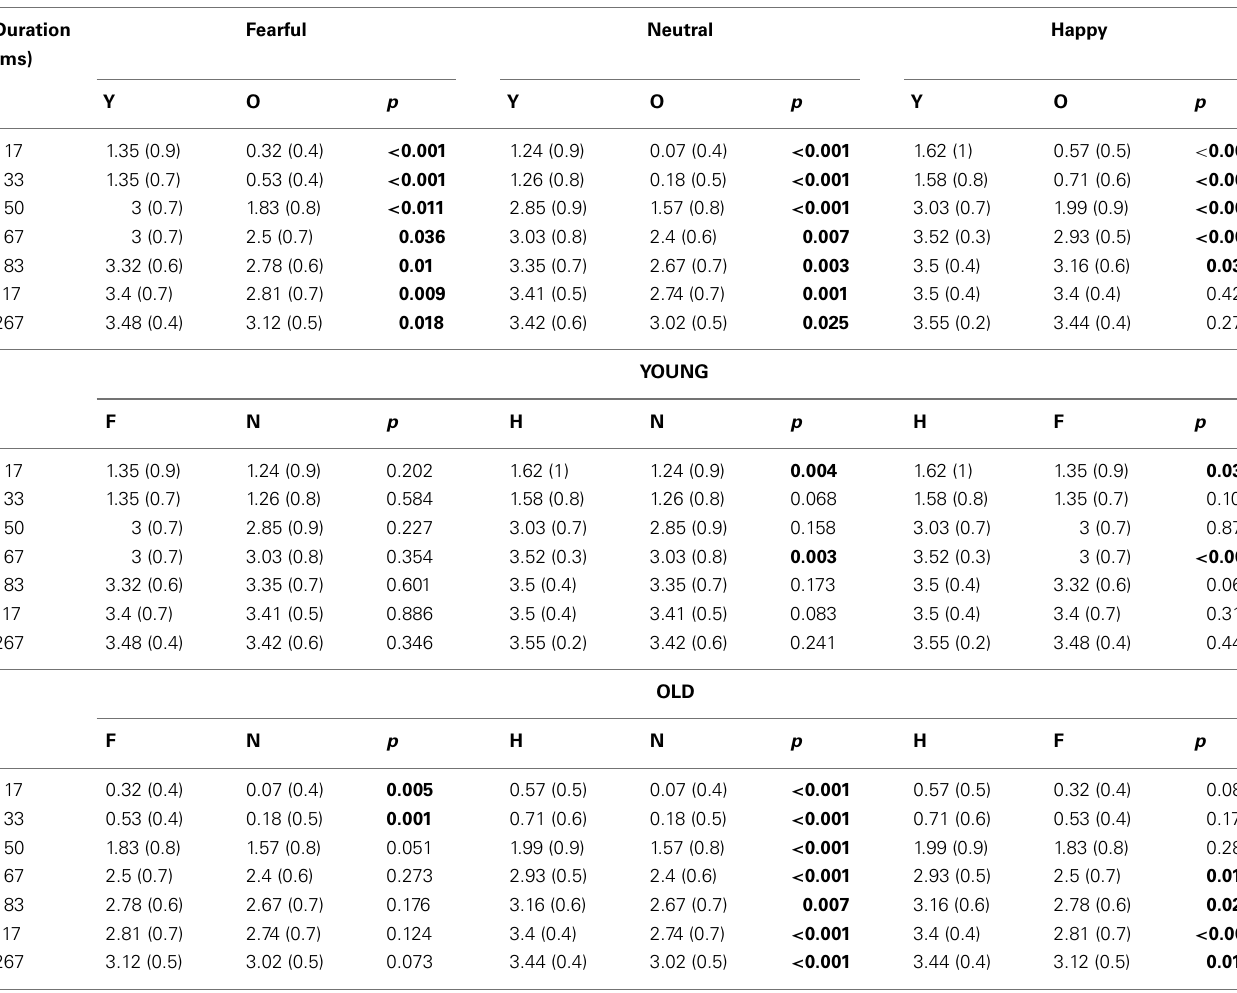
Table 2 | Mean d (cid:48) (and SDs) for masked recognition performance between and within age groups.